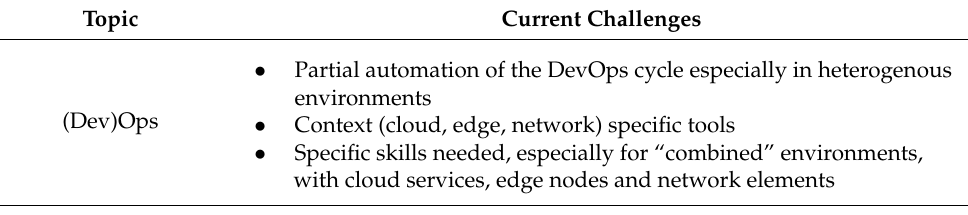
Table 1. Current unsolved challenges in the Operationalization of applications in the Cloud